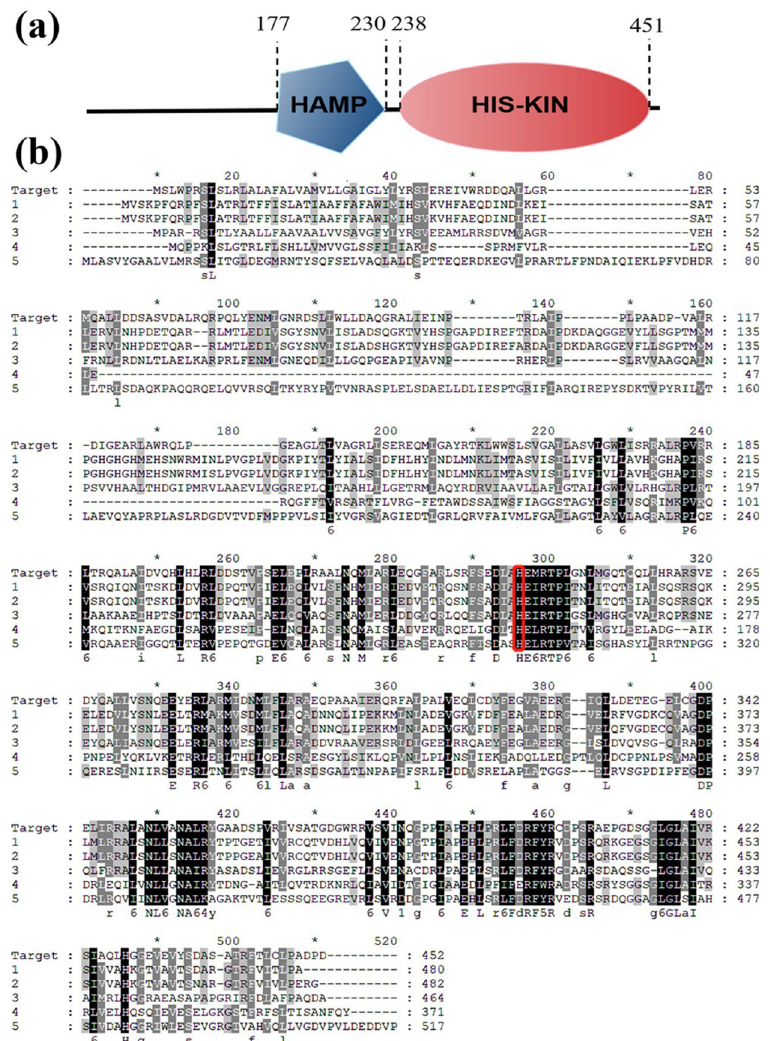
Fig 2. Domain organization of the TCS coded by the HK-1 gene. (a). Schematic map of the domain organization of the TCS coded by the HK-1 gene; (b). Amino acid sequence alignment of the target protein with five HAMP domains, the target protein is the target protein coded by the HK-1 gene in this study. 1, 2, 3, 4 and 5 are the amino acid sequences of five HAMP domains with high homology to low homology in Table 2, respectively.